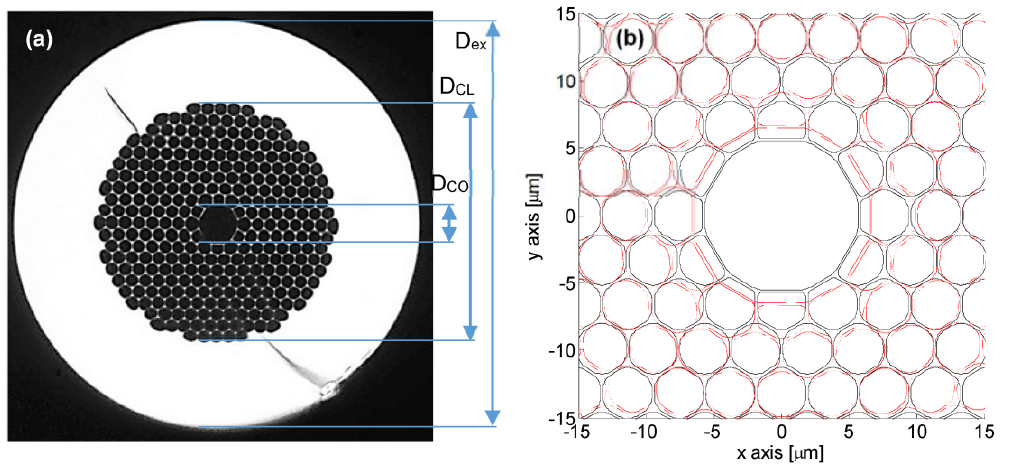
Figure 2. ( a ) Microscope image of the pristine fiber cross section; ( b ) Schematic view/comparison of the cross section of the pristine and perturbed fibers (achieved via Matlab): Solid black line is the pristine fiber, and dashed red line is the perturbed